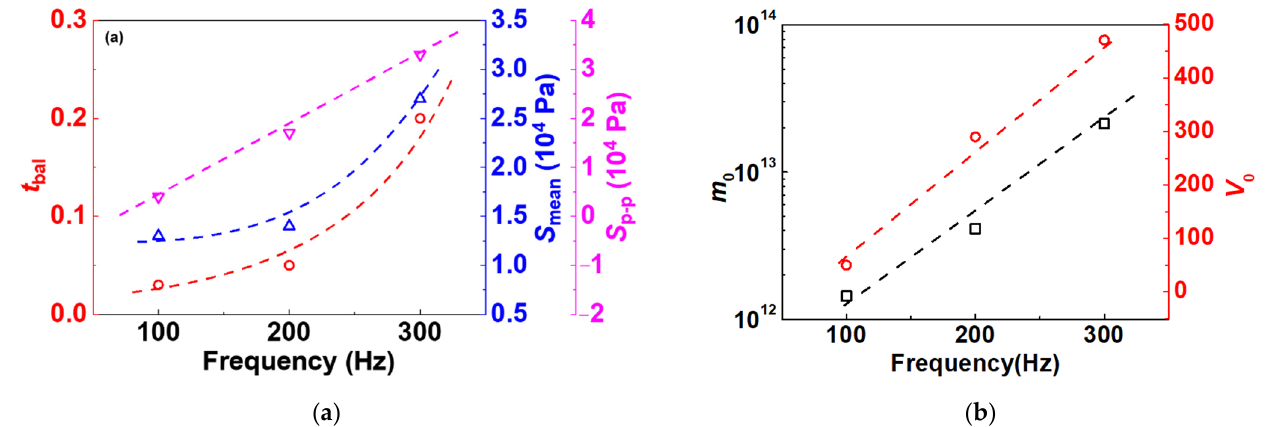
Figure 14. Changes of ( a ) time and ( b ) frequency domain characteristic parameters of axial compres- sive stress on the pressboard under different vibration frequencies. sive stress on the pressboard under different vibration frequencies.